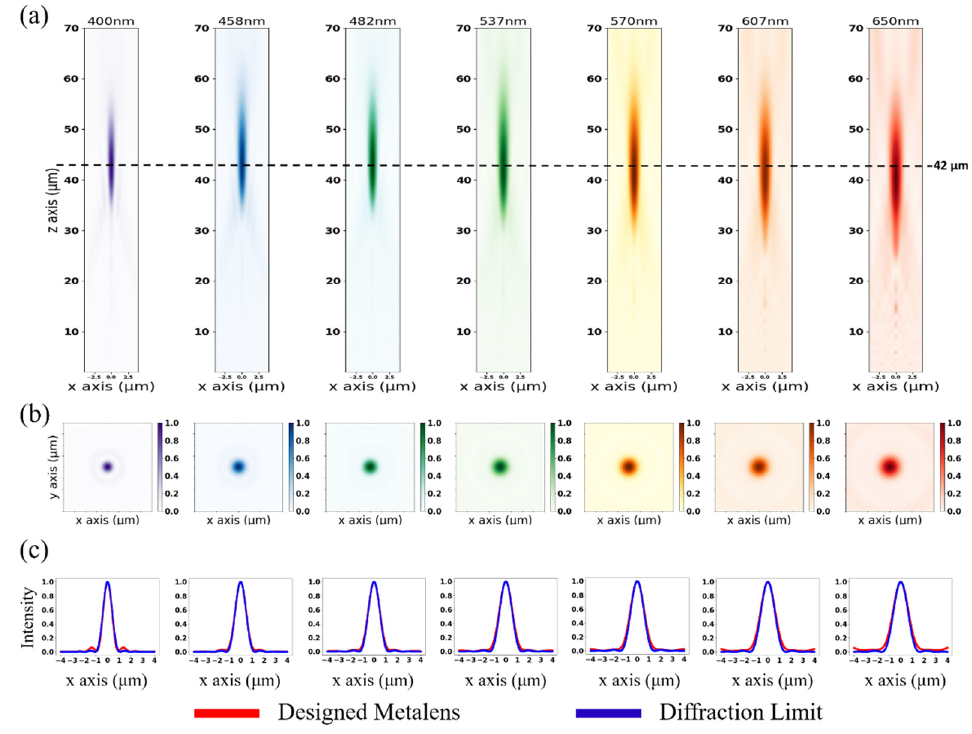
Figure 5. Far-field plots of broadband achromatic metalens for x-z, x-y, and cross-section along the X -axis. ( a ) Far-field on the x-z plane. ( b ) Far-field on the x-y plane. ( c ) Cross-section along the X -axis at the focus. The designed focus and NA are 42 μ m and 0.23, and the operating wavelengths are from 400 to 650 nm.